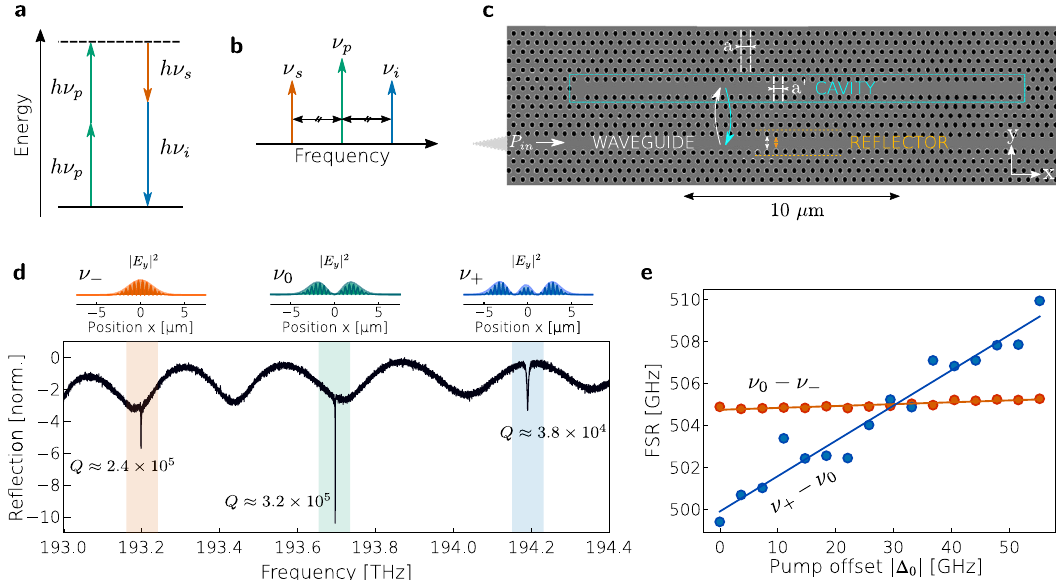
Fig. 1 Bichromatic photonic crystal cavity. a Schematic of the energy diagram for degenerate FWM, where two pump photons are converted into a signal and idler photons. Frequencies ( ν p , ν s , and ν i ) are dictated by energy conservation 2 ν p = ν s + ν i and h is Planck constant. b Corresponding schematic of the emission spectra, showing emission at ν s and ν i symmetrical to ν p . c SEM image of the cavity describing the different elements of the design. a and a' are the periods of the holes. P in is for the input power in the waveguide. White and orange arrows guide the eyes to see the shift of the lines of holes forming the re fl ector. d Re fl ection spectrum (measured with OCT) of the cavity limited to the fi rst three modes of frequencies ν − , ν 0 , and ν + used here for photon pair generation. The corresponding spatial pro fi le of the modes ∣ E y ∣ 2 are given above. Q is the Q-factor e Thermal tuning, the evolution of the Free Spectral Range ν 0 − ν − (red points) and ν + − ν 0 (blue points) as a function of the pump offset Δ 0 ¼ ν p (cid:2) ν 0 . Colored circles are measured with pump-probe OCT and continuous lines are linear fi t of the data. Equispaced con fi guration is reached at Δ 0 = 31